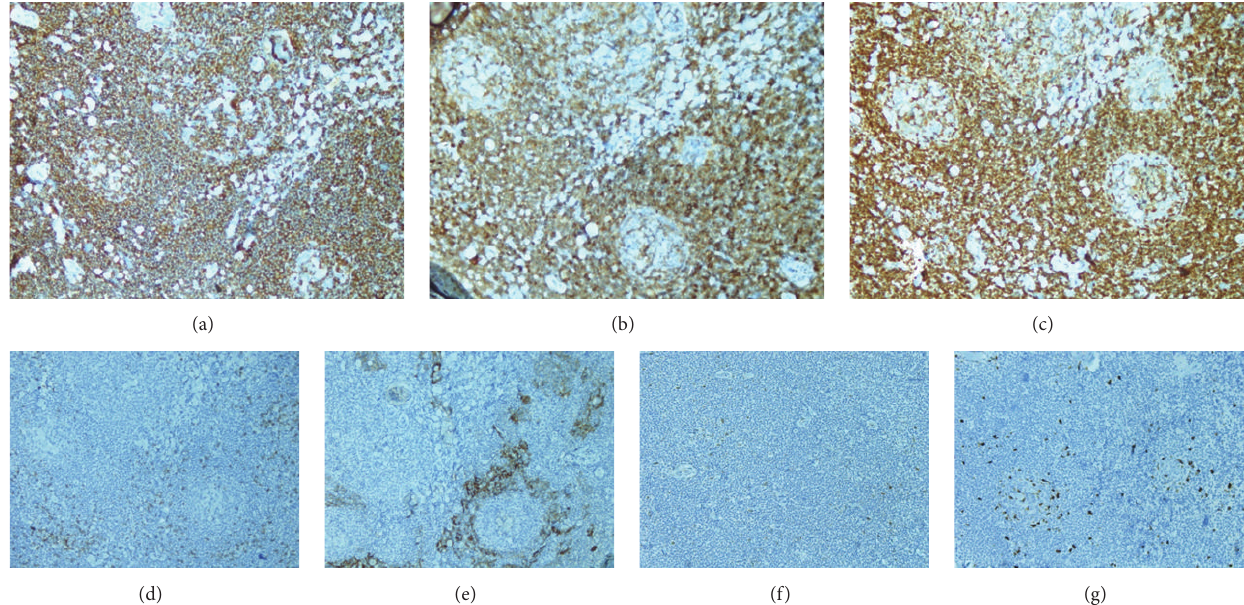
Figure 2: Immunohistochemically ( × 20), neoplastic infiltration was positive with CD20 (a), CD5 (b), and Bcl-2 (c) but negative with CD3 (d), CD23 (e), and cyclin D1 (f) and Ki67 revealed low proliferation index